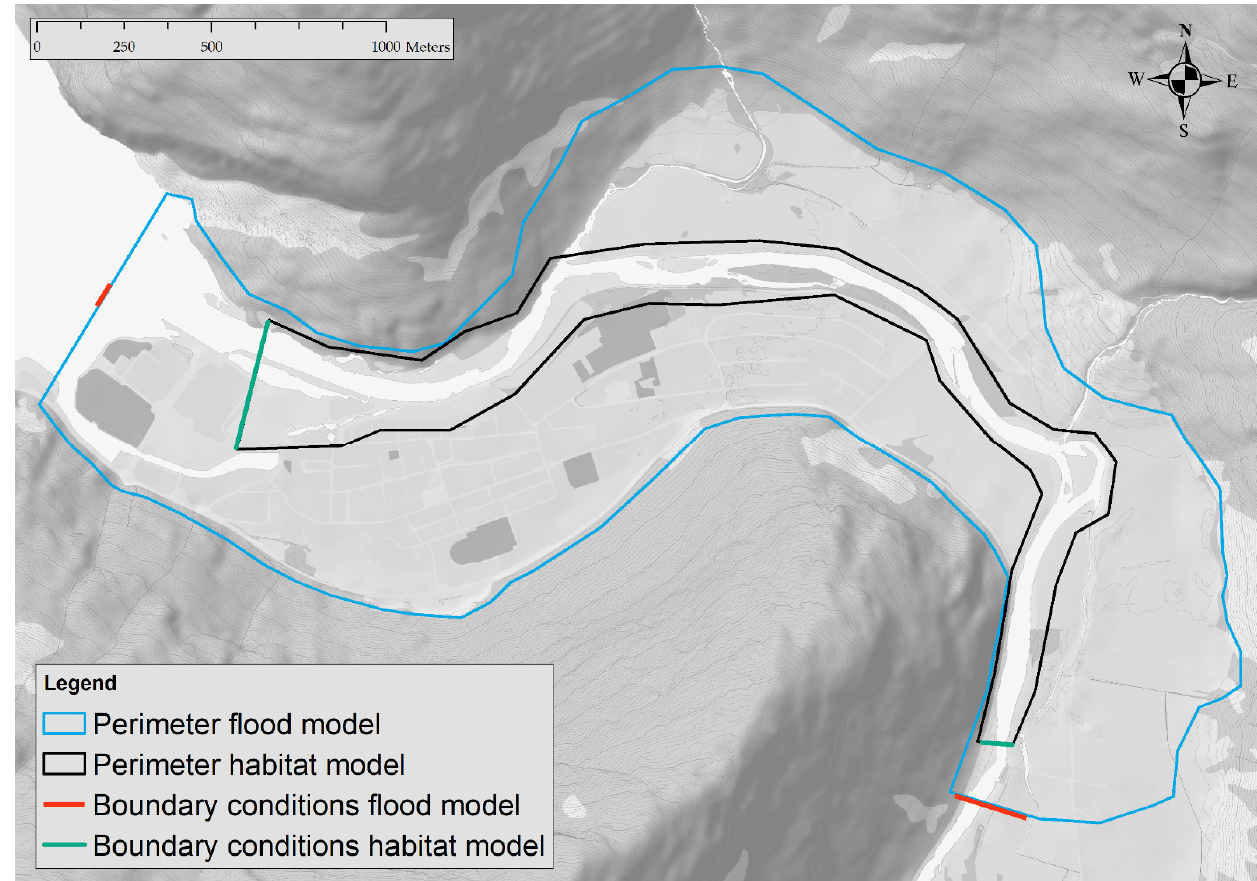
Figure 3. Location of the perimeters and boundary conditions in the HEC-RAS geometry for both the flood model and the habitat model.